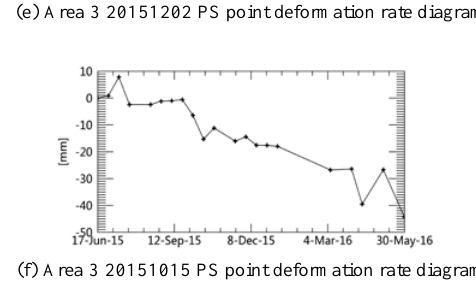
Figure 5. PS point deformation rate